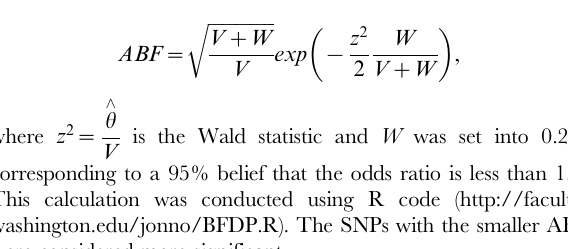
Figure S1 A quantile-quantile (QQ) plot for association results for training set. Figure S2 Relatedness among Japanese, Han Chinese, European and African individuals. The two-dimensional plots with the first and the second components showed that